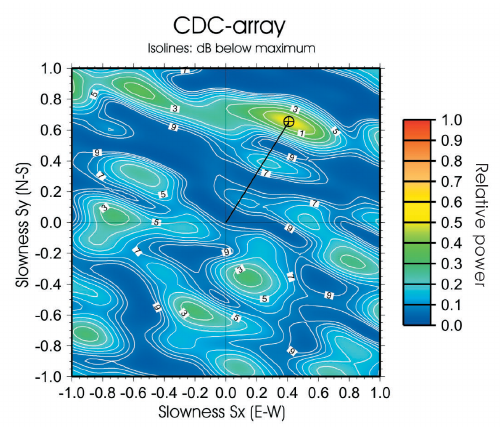
Fig. 12. F - k analysis of the coherent «3 Hz noise- signal», using nine vertical traces, bandpass filtered between 2-4 Hz. For the maximum peak level (rela- tive power=0.47) a low apparent velocity of v app =1.3 km/s was found, reaching the array from a back- azimuth of 31.7°.